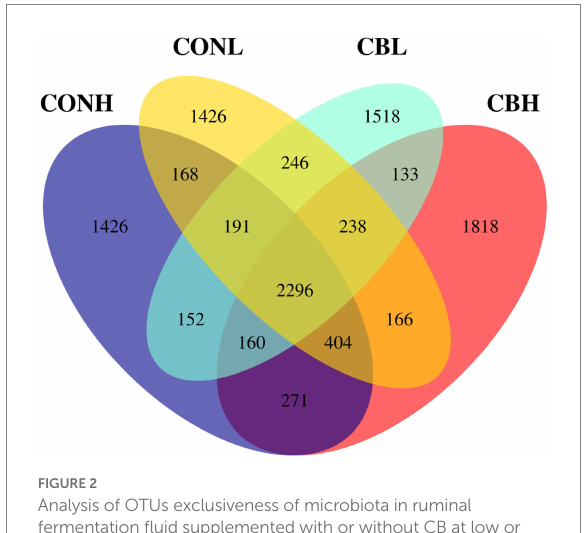
FIGURE 2 Analysis of OTUs exclusiveness of microbiota in ruminal fermentation fluid supplemented with or without CB at low or high media pH after 24 h of in vitro incubation. CONH, control at media pH 6.6; CONL, control at media pH 6.0; CBH, CB supplemented at 1 × 10 6 CFU/bottle at media pH 6.6; and CBL, CB supplemented at 1 × 10 6 CFU/bottle at media pH 6.0.